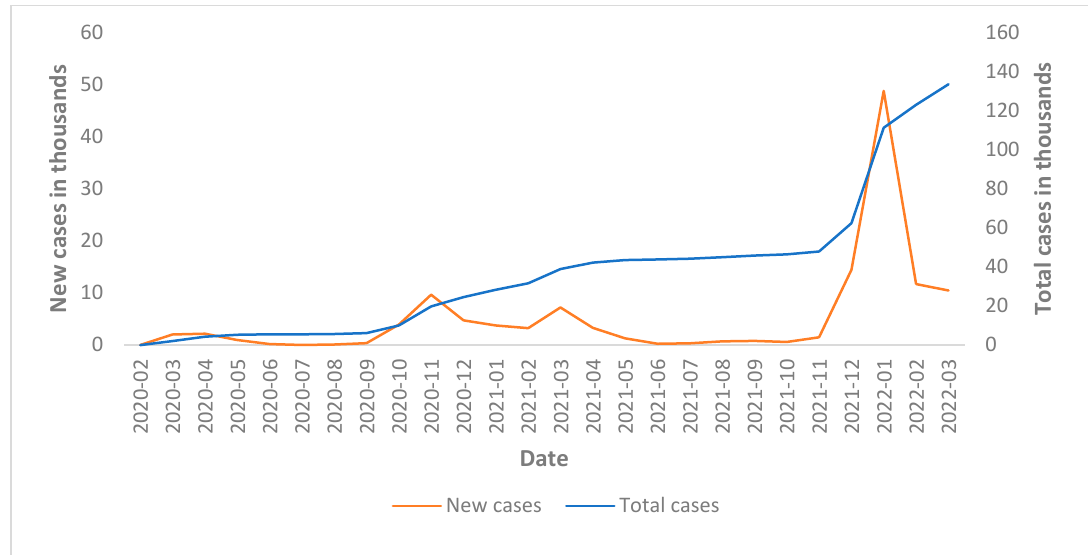
Figure 1. Trend of SARS-CoV-2 infections in the province of Pavia. Data from Italian Civil Protection—Contagion Rates [47].